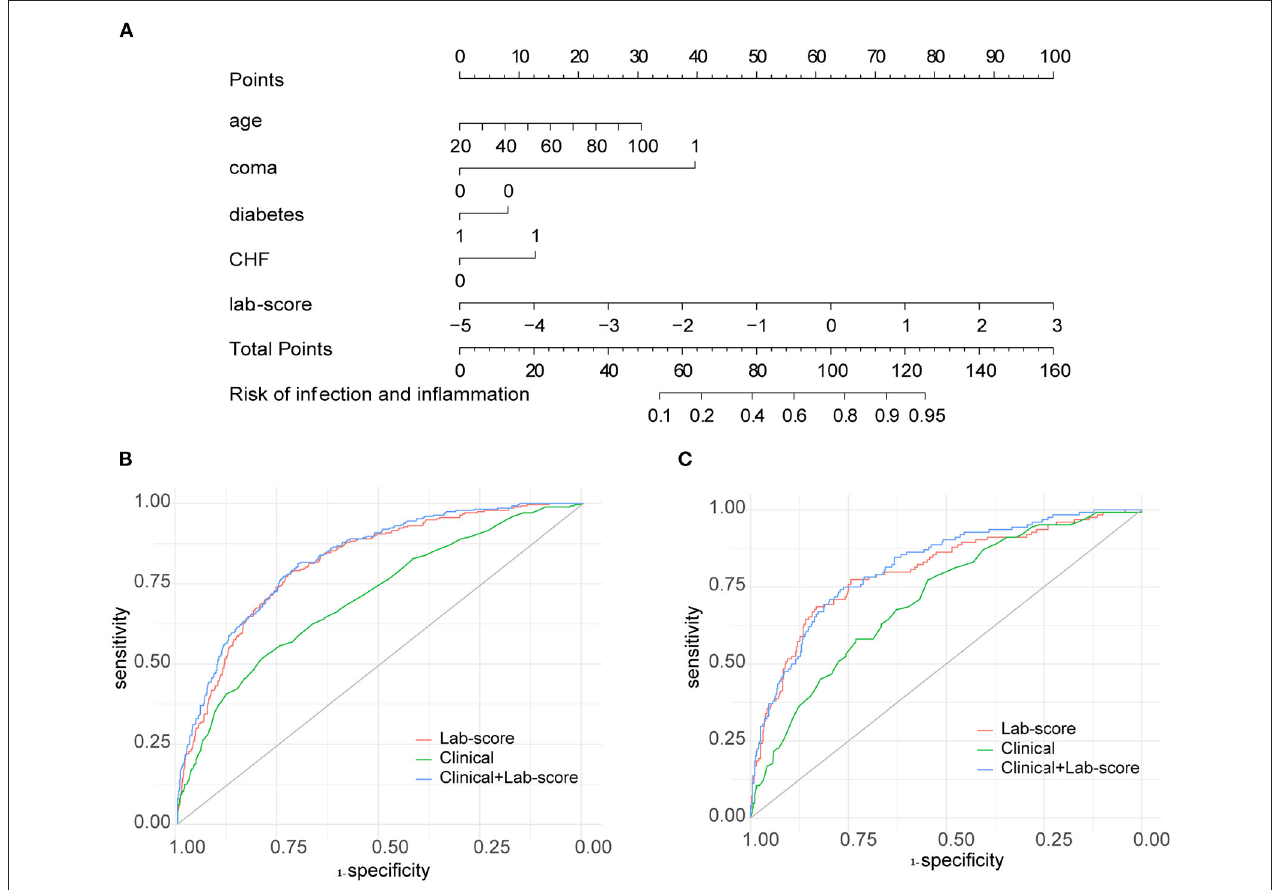
FIGURE 3 | Developed clinical lab nomogram. (A) The clinical-lab nomogram was developed in the derivation cohort, with the lab score, age, coma, diabetes, CHF incorporated. Receiver operating characteristic (ROC) curve analyses of the clinical, lab-score, and clinical-lab models on hematoma expansion in the derivation cohort (B) and validation cohort (C) .